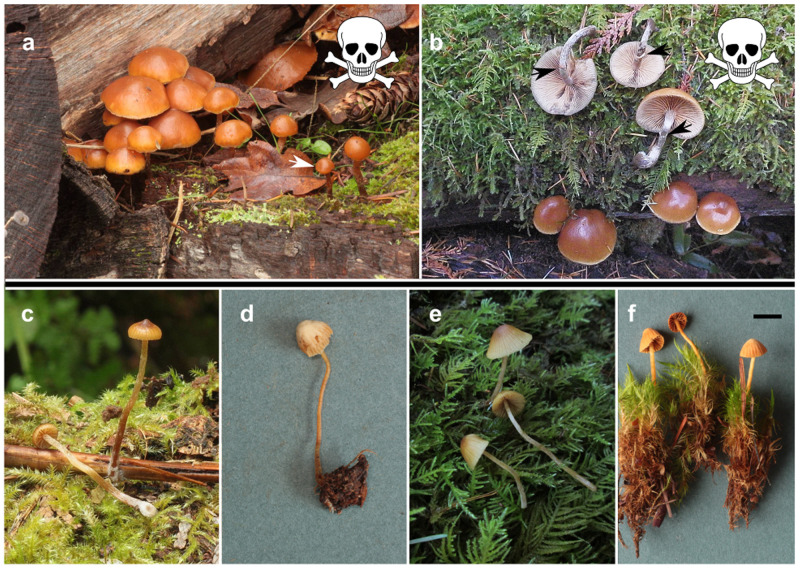
Toxin containing specimens in Galerina subgenus Naucoriopsis are shown in the top row; in the lower row are examples of species in the non-toxin producing subgenera.Each species name is followed by the specimen’s UBC voucher accession number; the Mushroom Observer photograph accession number; and in italics, the name of the subgenus that includes the species. (a, b) Specimens producing positive tests for amatoxins. (a) G. castaneipes F28078 MO119849, Naucoriopsis. White arrow points to inrolled cap margin in a young mushroom. (b) G. venenata F26281 MO153552 Naucoriopsis. Black arrows point to membranous rings around the stems. (c) G. nana F25541 MO102538 Naucoriopsis (affiliation is uncertain). (d) G. atkinsoniana F28226 MO137762 Galerina. (e) G. dimorphocystis F25868 MO129940 Tubariopsis. (f) G. subcerina F25303 MO84732 Mycenopsis. (d, e) Specimens not tested, but ITS sequences match specimens without detectable toxins. (f) Specimens tested, no toxins detected. Scale bar (f) is 1 cm. Scales are not available for the other images, but estimating from the mosses and cone, caps on mushrooms (a, b) are up to ~3 cm wide. Caps on mushrooms (c-f) are ~1 cm or less wide.